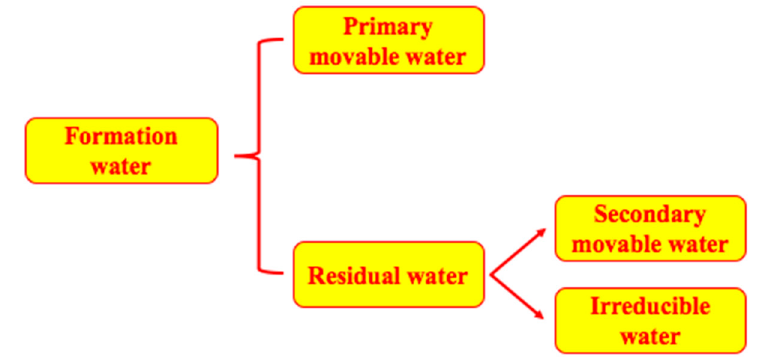
Figure 13. Classification of formation water in fracture-cavity carbonate reservoirs.